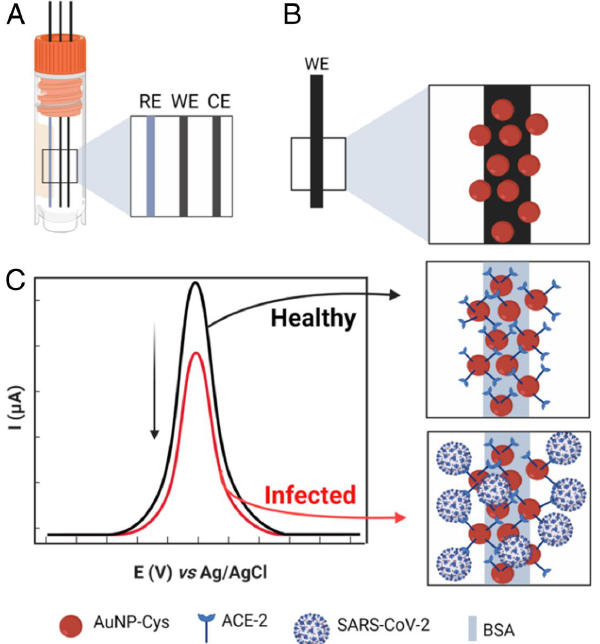
Figure 8. Schematic illustration of the biosensor fabrication and detection principle. ( A ), Electrode system of the developed sensor. ( B ), Functionalization of working electrode. ( C ), Detection principle. RE, reference electrode; WE, working electrode; CE, counter electrode. Adapted from Ref. [52] with permission from authors. Copyright © 2021, the authors. This article is licensed under a Creative on 21 October